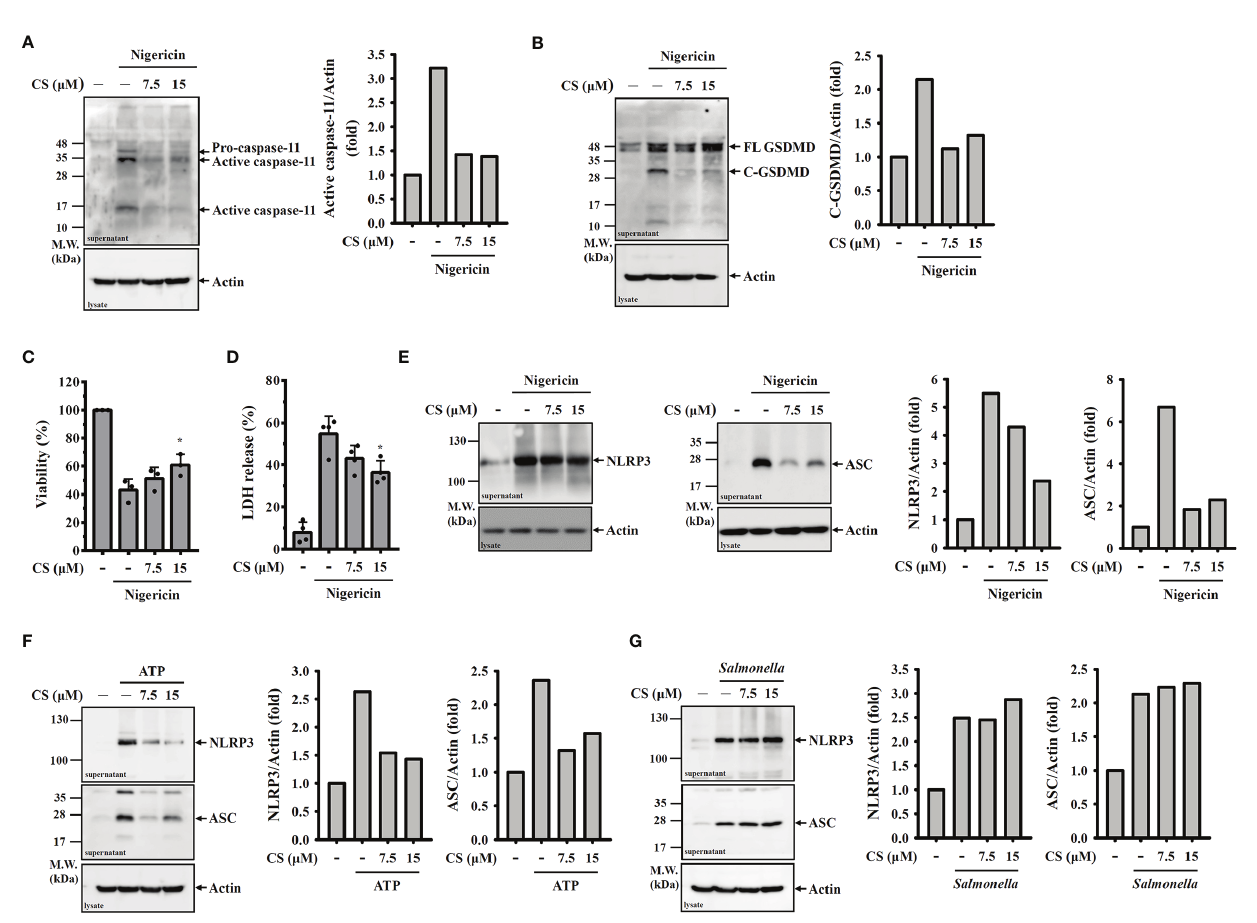
FIGURE 2 | CS inhibits pyroptosis. (A – E) J774A.1 macrophages were primed with LPS for 5 h and incubated with CS for 0.5 h Cells were stimulated with 10 m M nigericin for 0.5 h The levels of caspase-11 (A) and GSDMD (B) in the supernatants were measured by Western blot. Cell viability was measured by the AlamarBlue assay (C) , and the levels of LDH in the supernatants were measured by the LDH release assay (D) . The levels of NLRP3 and ASC in the supernatants were measured by Western blot (E) . (F, G) J774A.1 macrophages were primed with LPS for 5 h and incubated with CS for 0.5 h Cells were stimulated with 5 mM ATP for 0.5 h (F) or infected with Salmonella for 2 h (G) . The levels of NLRP3 and ASC in the supernatants were measured by Western blot. The cell viability and LDH release data are expressed as the means ± SD of the three separate experiments. The Western blot images are representative results, and the histogram shows the band intensity. * indicates a signi fi cant difference at the level of p <0.05 compared to nigericin-activated